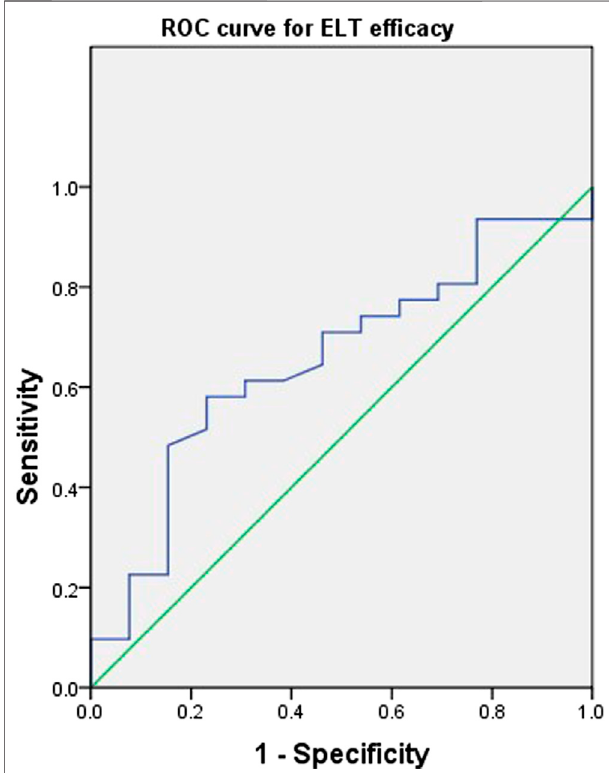
FIGURE3| Receiver operatingcharacteristiccurvesoftheEltrombopag concentration and ef fi cacy for 44 patients with refractory nonsevere aplastic anemia. A plot of test sensitivity ( y coordinate) vs. the false positive rate ( x coordinate)wasobtainedateachcutofflevel.Theareaunderthesmooth ROC curve and its 95% CI were 0.65 and 0.48 – 0.83, respectively.